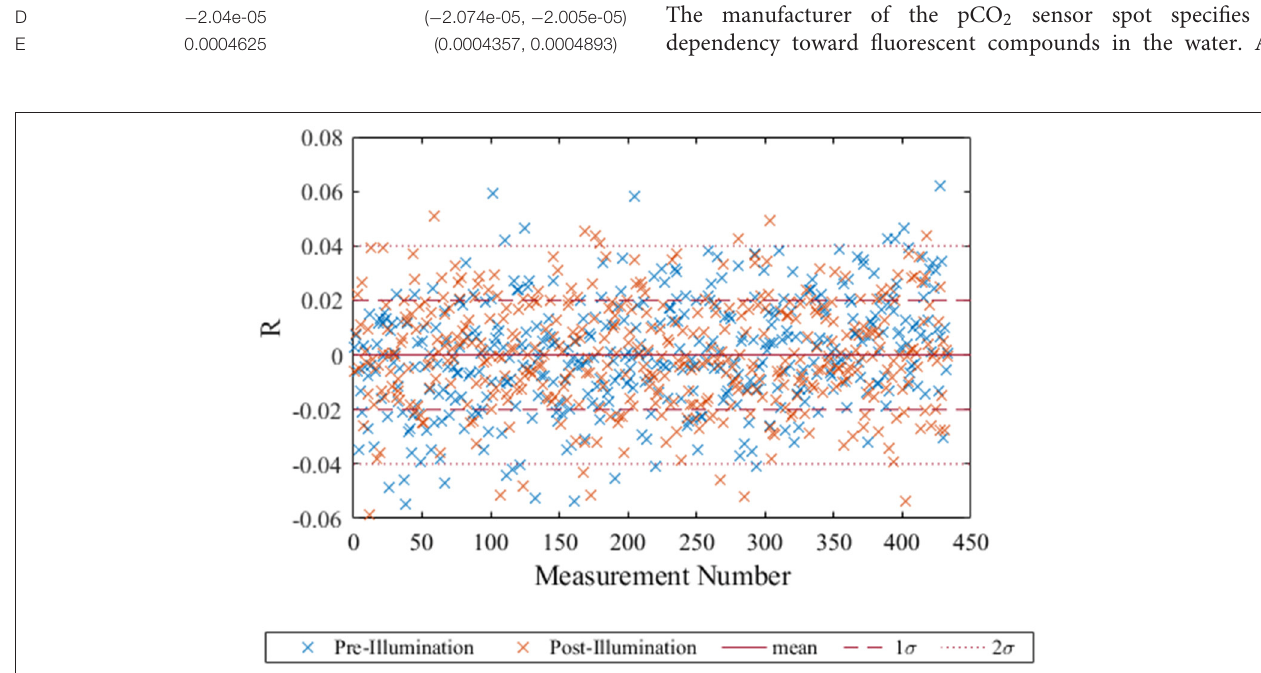
FIGURE 4 | The residuals of R (mean–observed) for each of the post-bleach and pre-bleach measurements with the blue crosses representing the pre-bleach measurement and the orange the post-bleach measurement. The mean, 1 σ and 2 σ were calculated for the pre-bleach measurements and plotted here with red dashed and dotted line respectively. The straight red line indicates where measured values are the same as the mean.